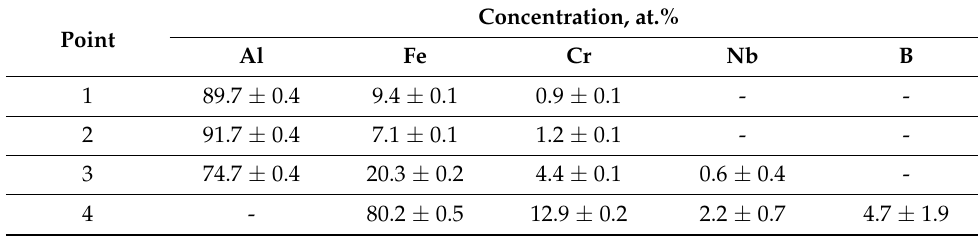
Figure 4. Line EDS of a partially reacted alloy particle in the residual Al matrix in the composite obtained by SPS of Al–50 vol.% Fe 66 Cr 10 Nb 5 B 19 . SPS conditions: temperature—570 °C, holding time—3 min, applied pressure—40 MPa.